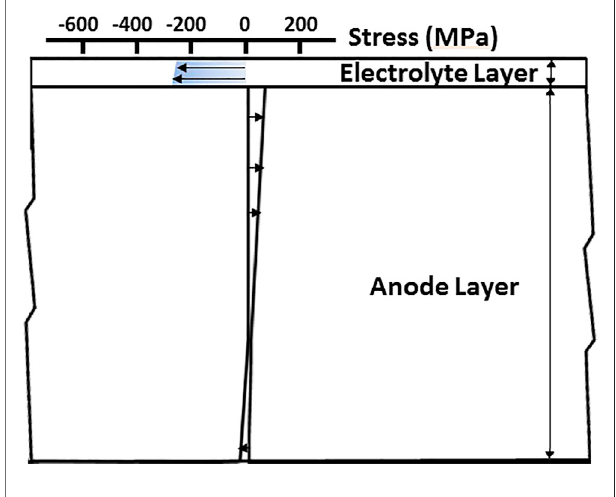
FIGURE 1 | Schematic diagram of the cross-sectional view of the residual stress distribution in an anode supported cell at room temperature.